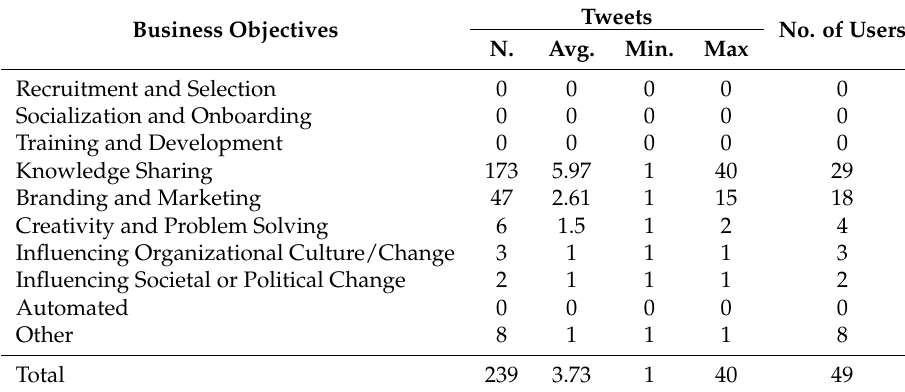
Table 11. Business Objectives of Non-Media Businesses.